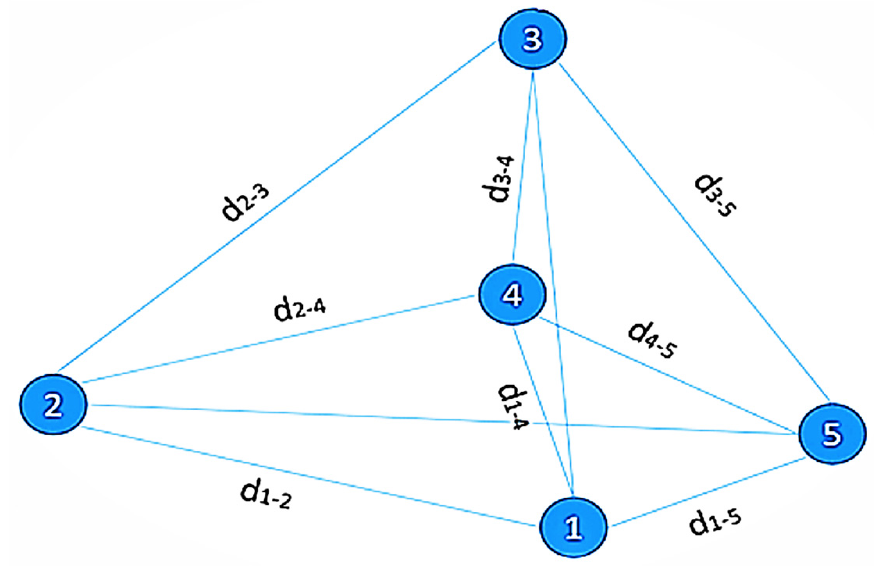
Figure 2. Space of expert opinions.